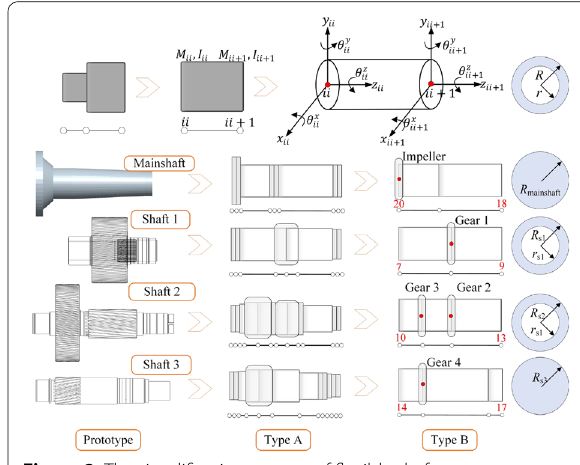
Figure 2 The simplification process of flexible shafts